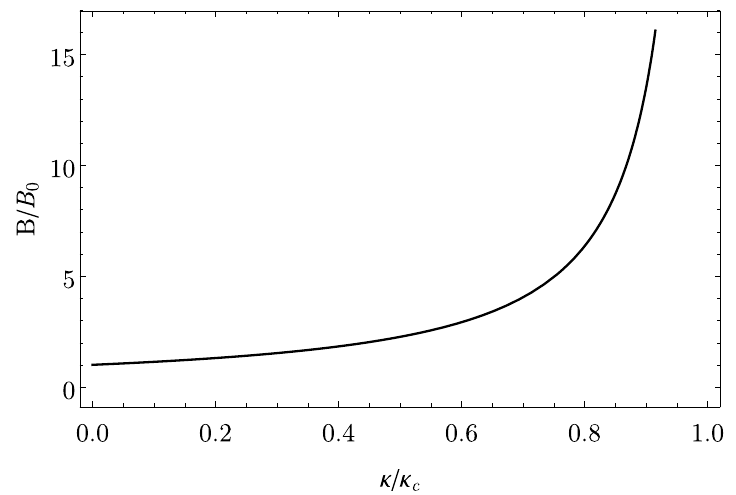
Figure 6. The ratio of the tunneling exponent for vacuum decay B = B vac as the function of κ/κ c